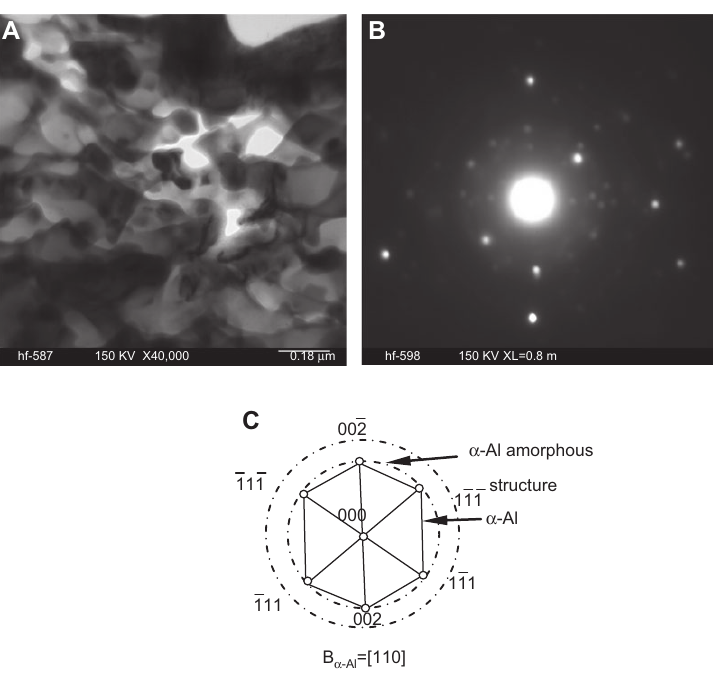
Figure 3 The TEM analysis of the surface composite. (A) TEM image of UFG structure. (B) Selected area of electron diffraction pattern. (C) Schematic index diagram of the panel.